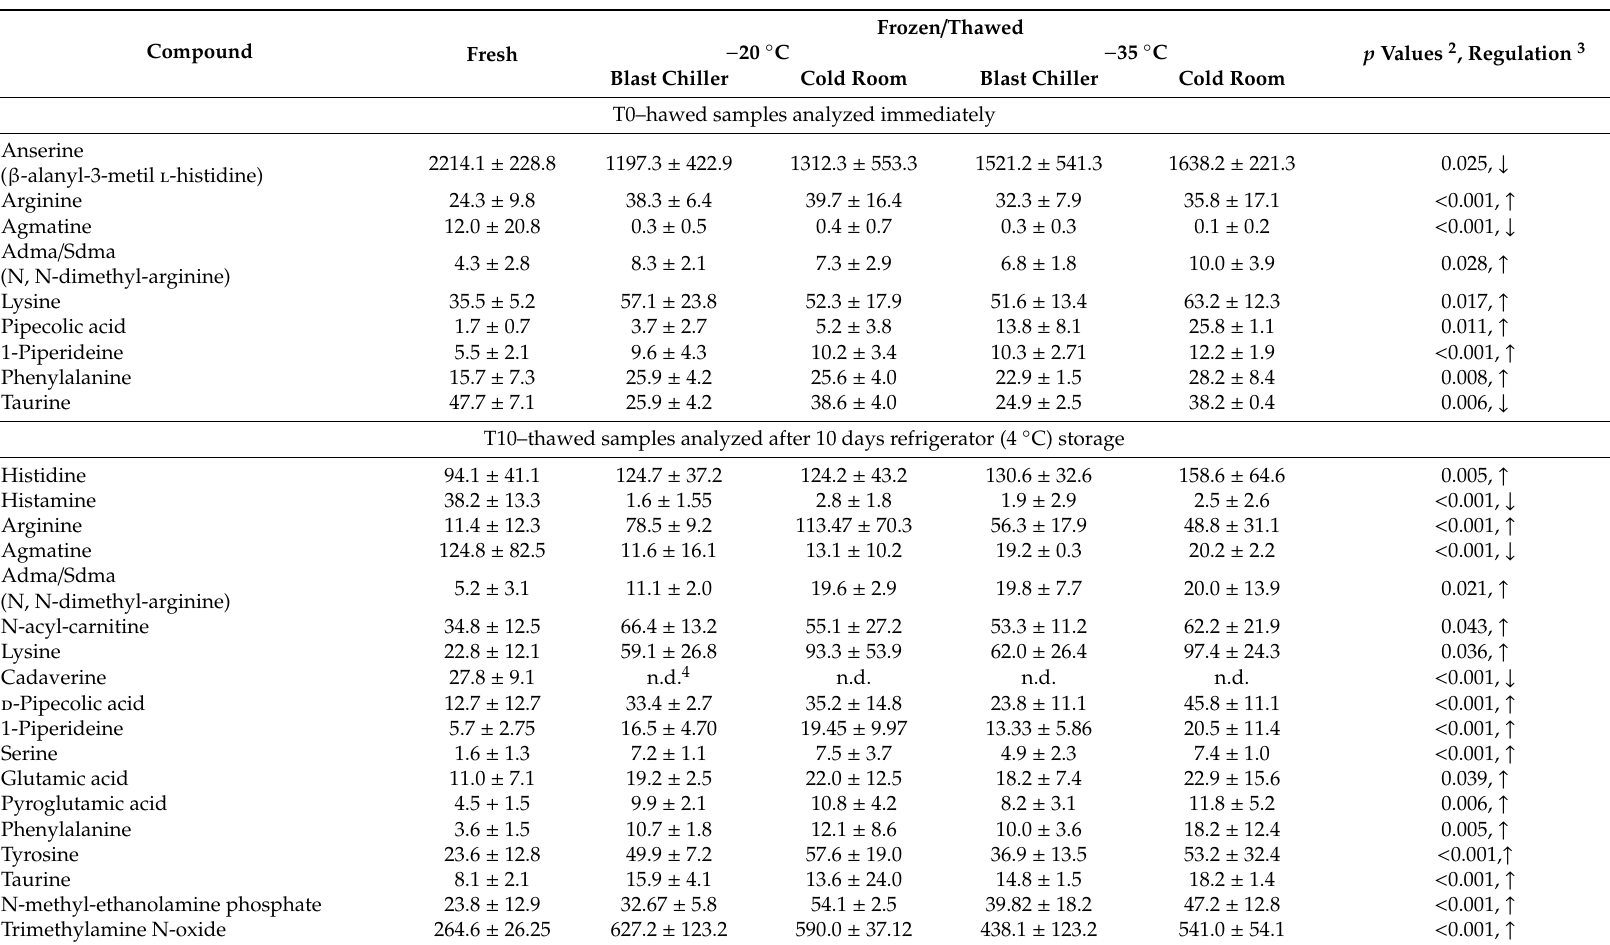
Table 2. The main di ff erentiators detected in salmon samples as proposed markers for fresh and frozen discrimination (mean ± SD; µ g / IS equivalents 1